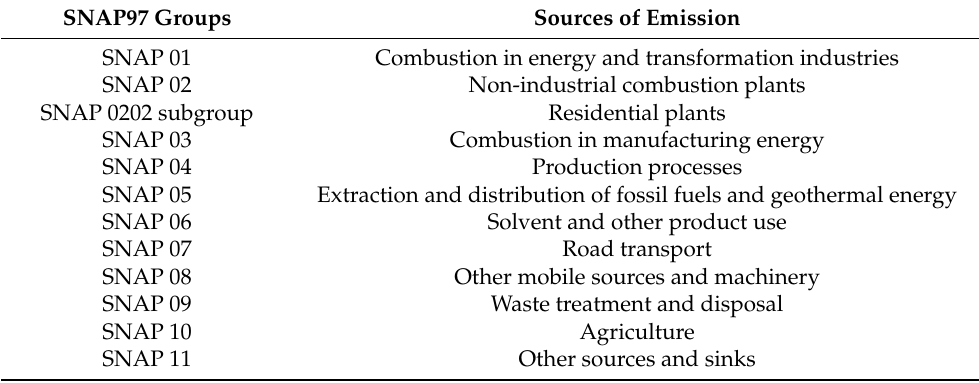
Table 8. Selected Nomenclature for sources of Air Pollution (SNAP) 97 classification groups [49].